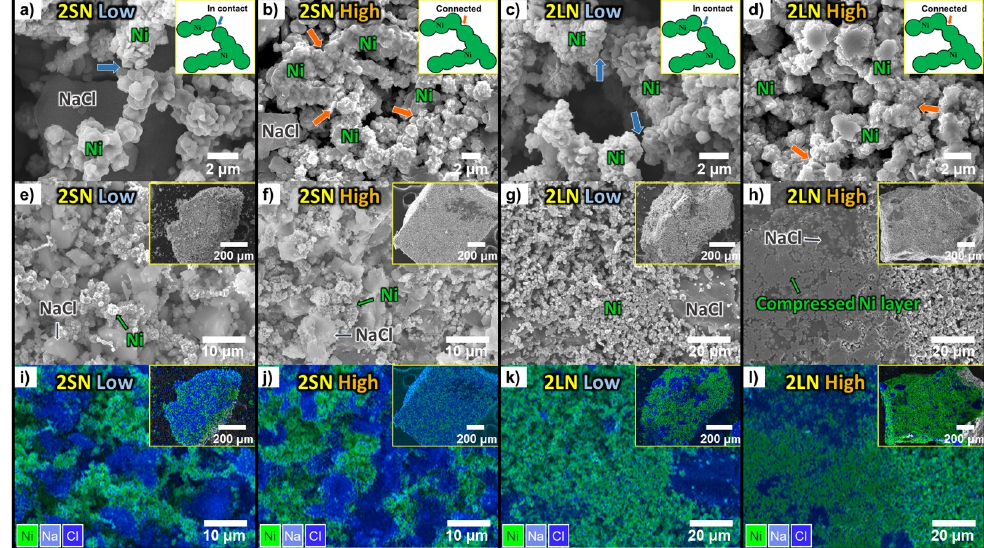
Figure 2. SEM images of cathode granule in 2SN and 2LN with different granule densities. ( a – d ) shape of Ni connection in each condition; ( e – h ) granule surface and microstructure of each cell; ( i – l ) EDS mapping data of each cell. (green: Ni, blue: NaCl).